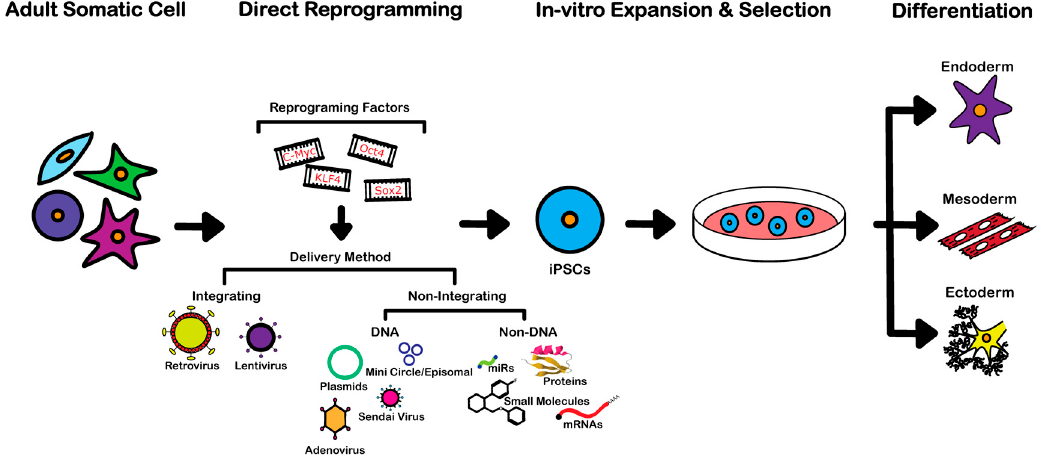
Figure 2. The direct reprogramming of somatic cells to induced pluripotent stem cells (iPSCs) can be achieved through the ectopic expression of specific transcription factors: Oct-4 , C-Myc , Sox-2 and Klf-4 , the “Yamanaka or OSKM Factors”. Delivery of these factors can be accomplished through a variety of methods. Initial methods developed integrating retroviral or lentiviral vectors. More recent strategies utilized non-integrating methods, further categorized by the use of DNA such as plasmids, mini circles/episomal, adenovirus, Sendai virus, and non-DNA based procedures such as, mRNAs, microRNAs (miRs), small molecules and bioactive proteins. Once reprogrammed to a pluripotent state, iPSCs can be expanded in vitro and subsequently differentiated to ectoderm, mesoderm and endoderm linages for use in cell therapy, disease modeling and drug discovery.